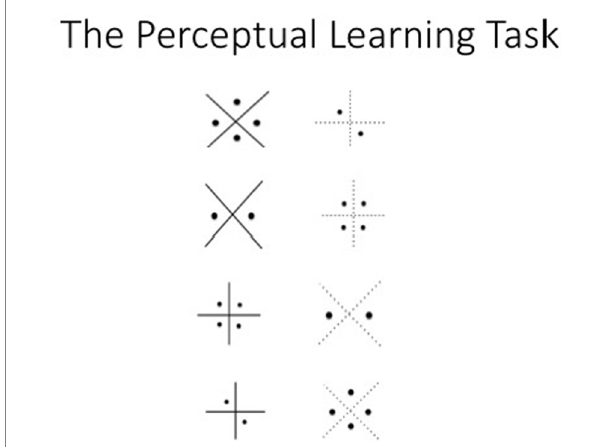
FIGURE 1 Stimuli Presented in the Perceptual Learning